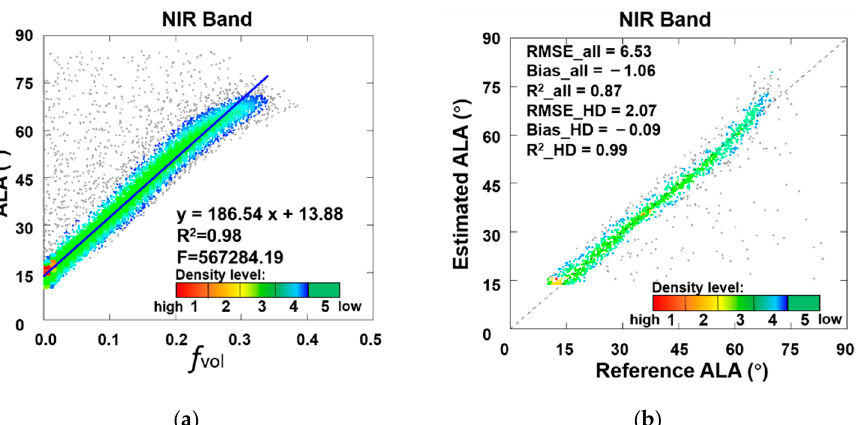
Figure 4. Regression and evaluation of the linear relationships between the ALA and f vol in the NIR band: ( a ) the optimal linear regression relationships based on the modelling data; ( b ) comparison of the estimated ALA to the reference value based on the independent evaluation data.